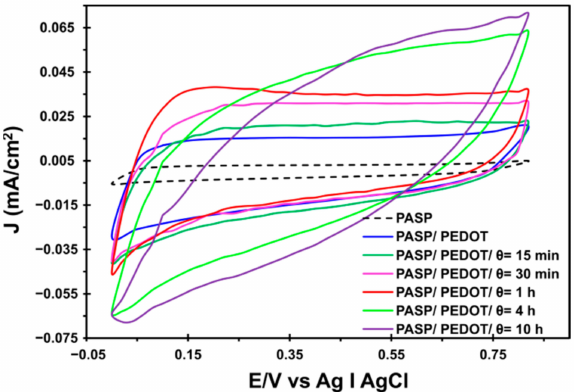
Figure 7. Control voltammograms (second cycle) for PASP/PEDOT hydrogel and [PASP/PEDOT] PHMeDOT hydrogel prepared using different electropolymerization times ( θ = 15 min, 30 min, 1 h, 4 h, and 10 h).